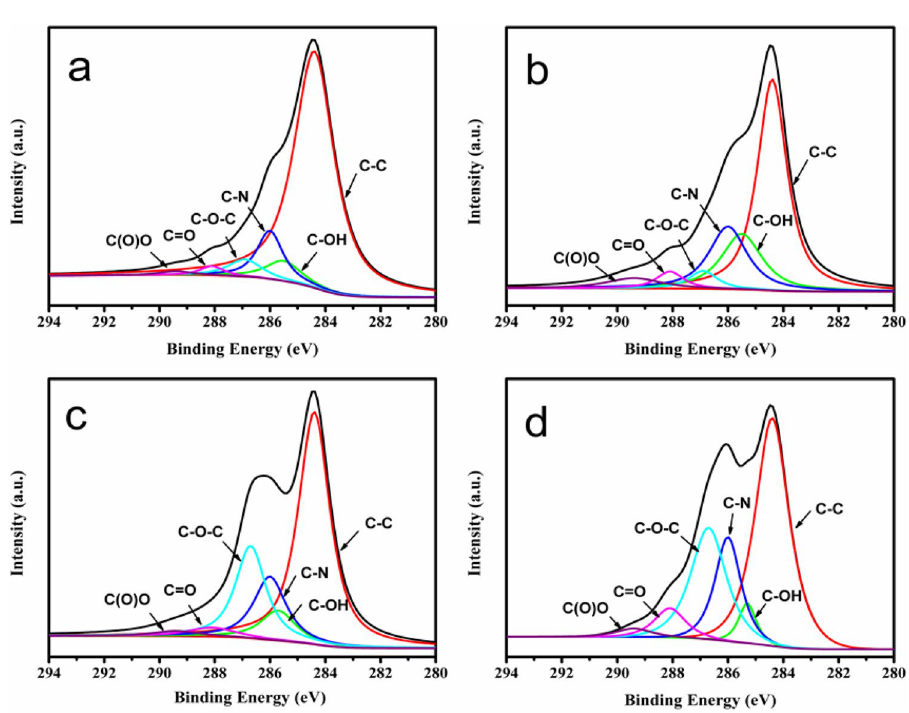
Figure 7. XPS spectra of ( a ) P-GCP-1, ( b ) P-GCP-2, ( c ) P-GCP-3, and ( d ) P-GCP-4 ternary artificial nacre